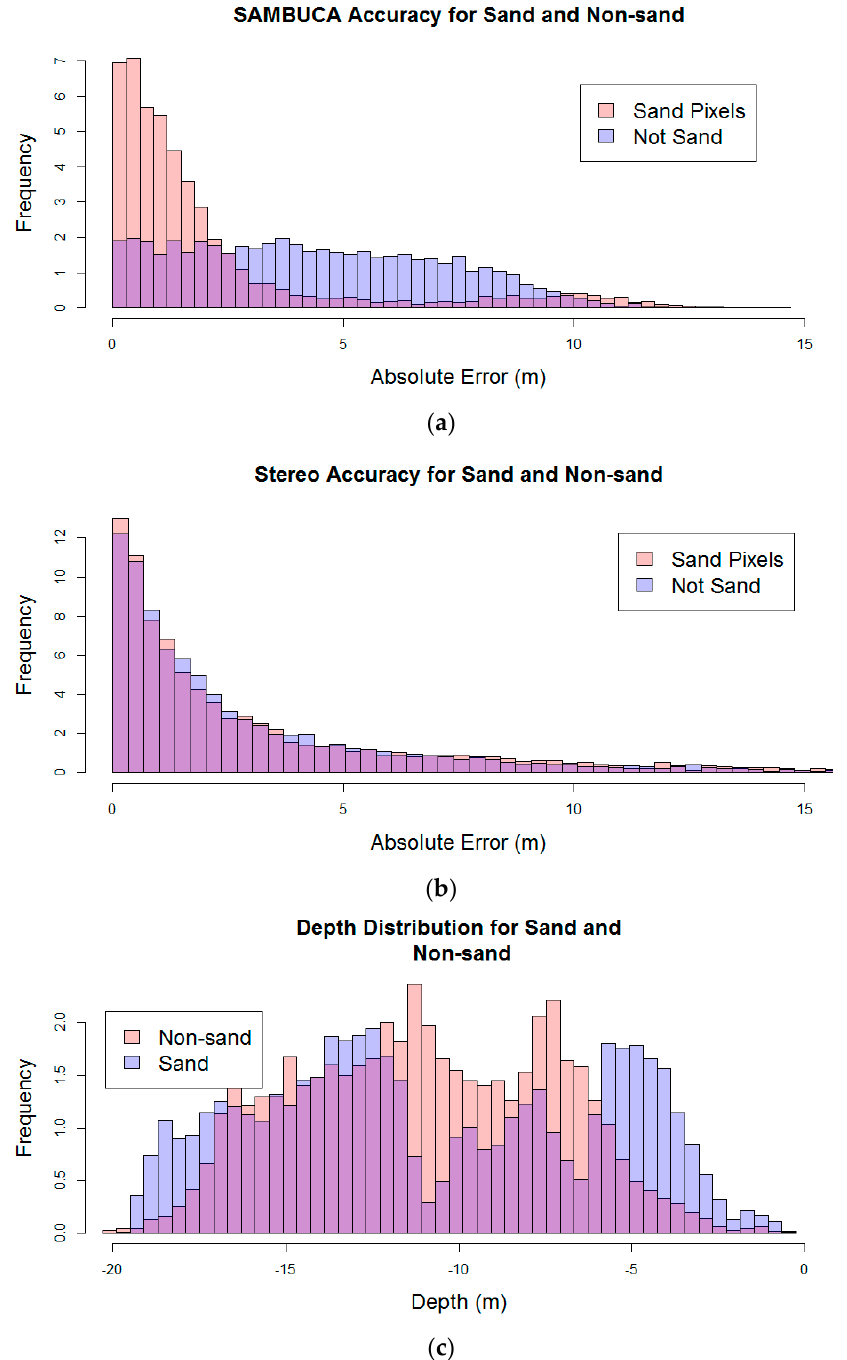
Figure 10. ( a ) Distributions of absolute errors for different classes for SAMBUCA. ( b ) Distributions of absolute errors for different classes for stereo. ( c ) Depth distribution for sand and non-sand pixels.